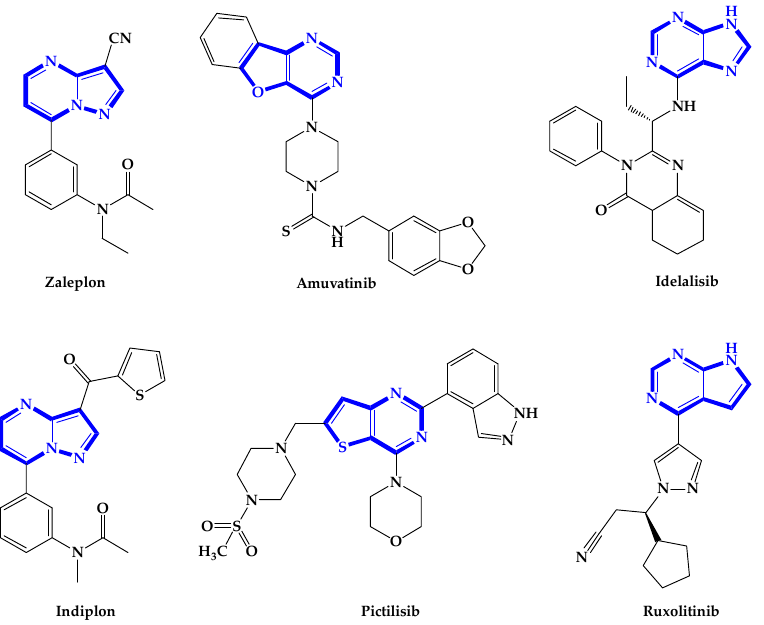
Figure 1. Structures of some Food and Drug Administration (FDA) approved drugs with the bicyclic scaffold reported in this article.